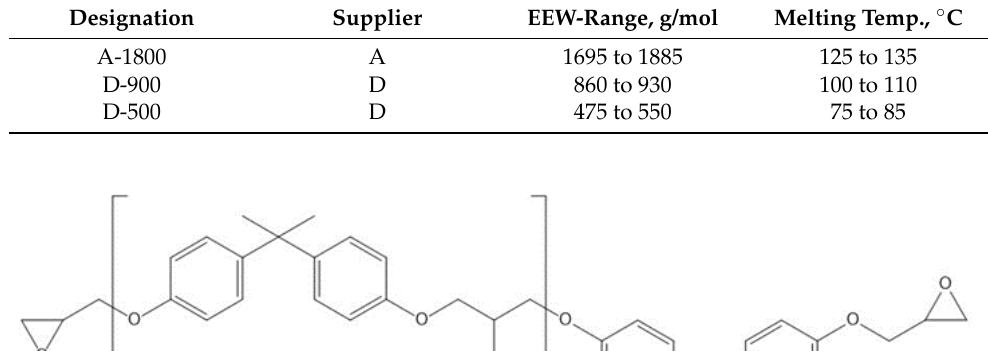
Table 1. Used epoxy base resins along with the designation, the supplier, the EEW value range and the estimated melting temperature (T M ).